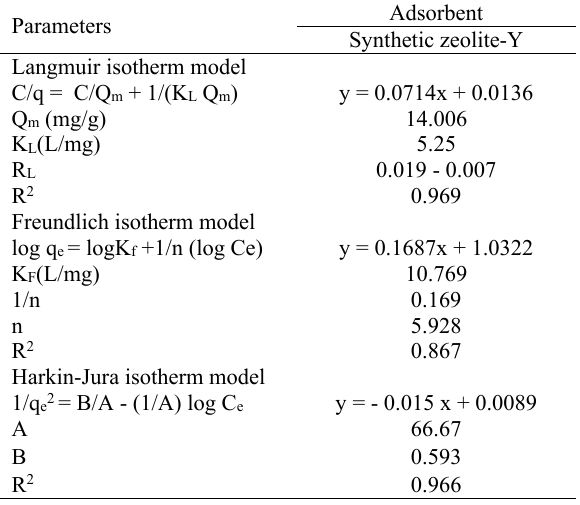
Langmuir, Freundlich and Harkin-Jura isotherm constants for the adsorption of Cd 2+ ions onto synthetic zeolite-Y.